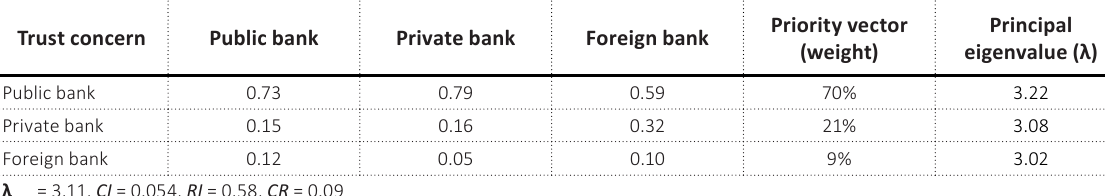
Table 10. Normalized weighted scores of various aspects of